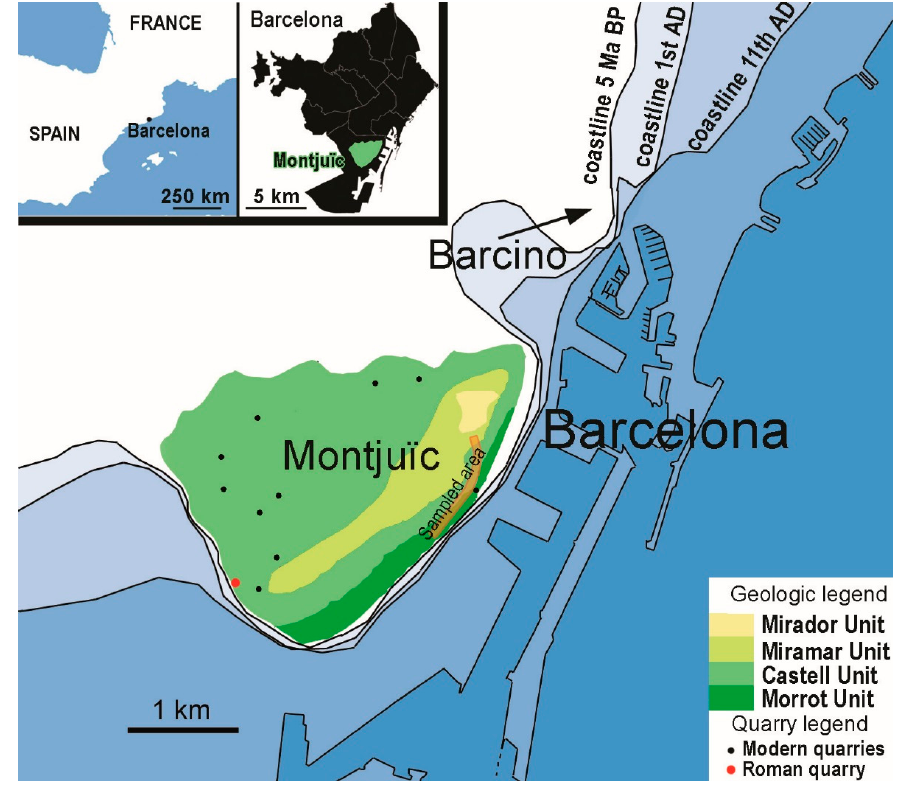
Figure 1. Geological map of the Montjuïc hill and its quarry sites. The position of Roman Barcino and the evolution of the coastline are also depicted. Upper insets: Location of Barcelona in Spain and location of Montjuïc within the Barcelona municipality.